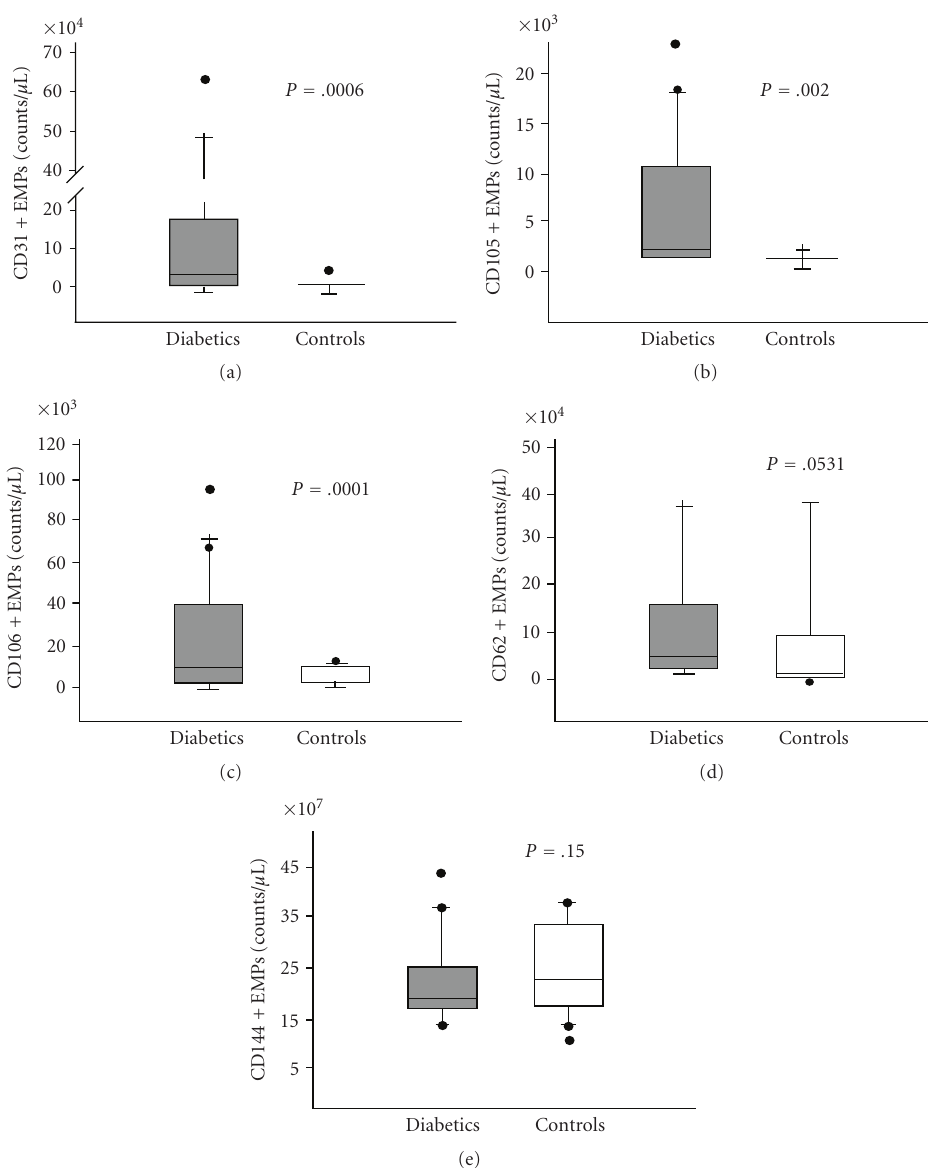
Figure 3: Diabetic patients had significantly increased absolute number EMPs compared to controls. Box-and-whisker plot showing plasma values in patients with and without DM: CD31+/CD41 − EMP (a), CD 105+ EMP (b), and CD 106+ EMP (c). In these plots, lines within boxes represent median values; the upper and lower lines of the boxes represent the 25th and 75th percentiles, respectively; the upper and lower bars outside the boxes represent the 90th and 10th percentiles,